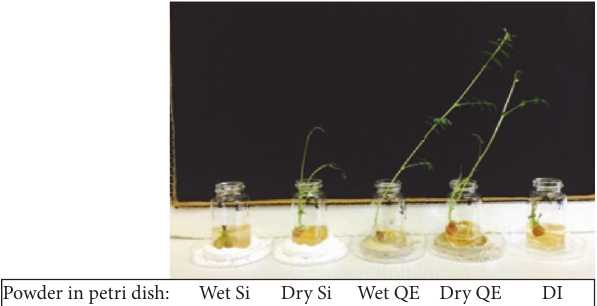
Figure 14: Representative images of sapling growth in the noncon- tact model or the “seed in vial; powder in petri-dish” setup during a 30-day growth